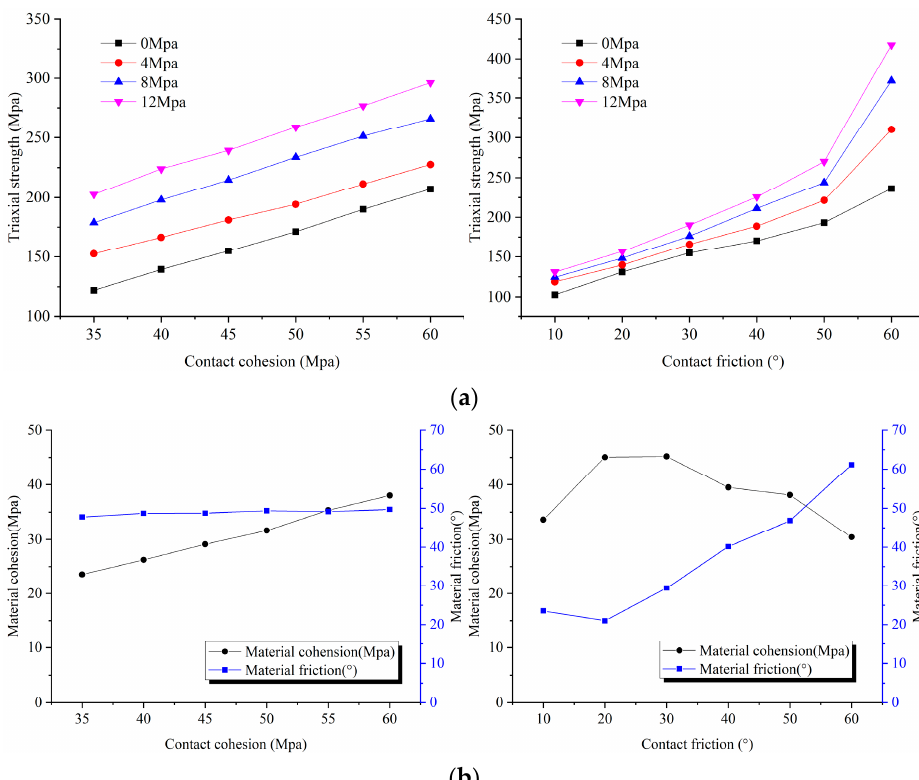
Figure 3. Effect of contact cohesion ( c j ) and contact friction angle ( ϕ j ) on ( a ) the material triaxial compressive strength; ( b ) the material friction angle and cohesion.